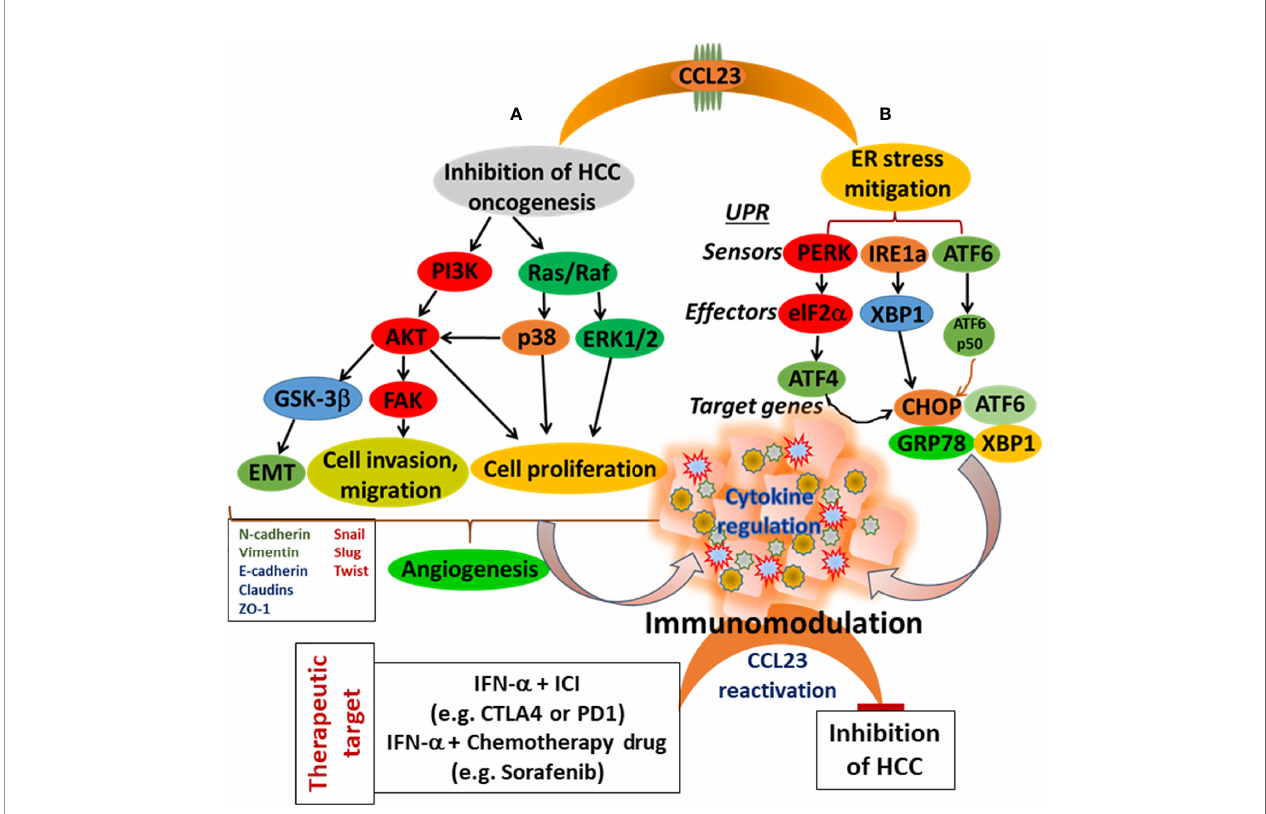
FIGURE 3 | Schematic presentation of CCL23 functions for the modulation of the HCC tumor microenvironment. (A) Targeting cellular signaling cascade inhibiting HCC cell progression, and (B) Mitigating of ER stress. Both events lead to immunomodulation with a potential to enhance antitumor